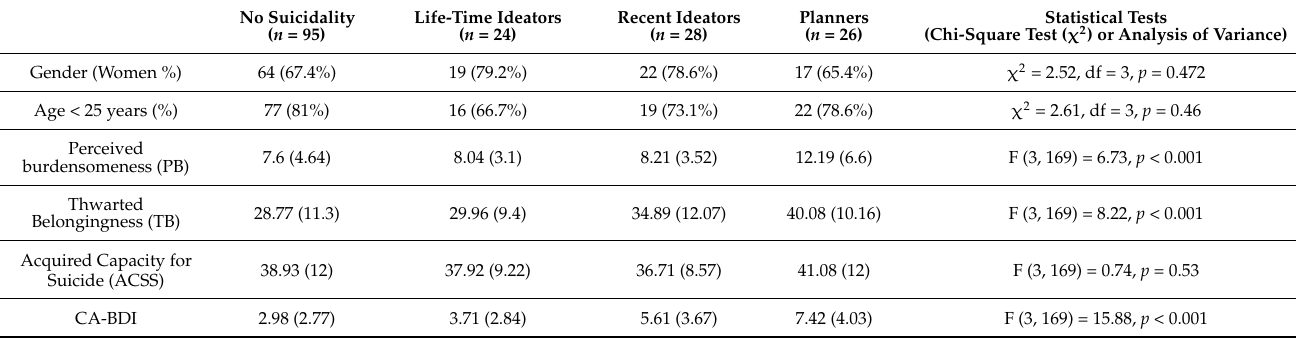
Table 1. Demographic and psychometrical variables in the different